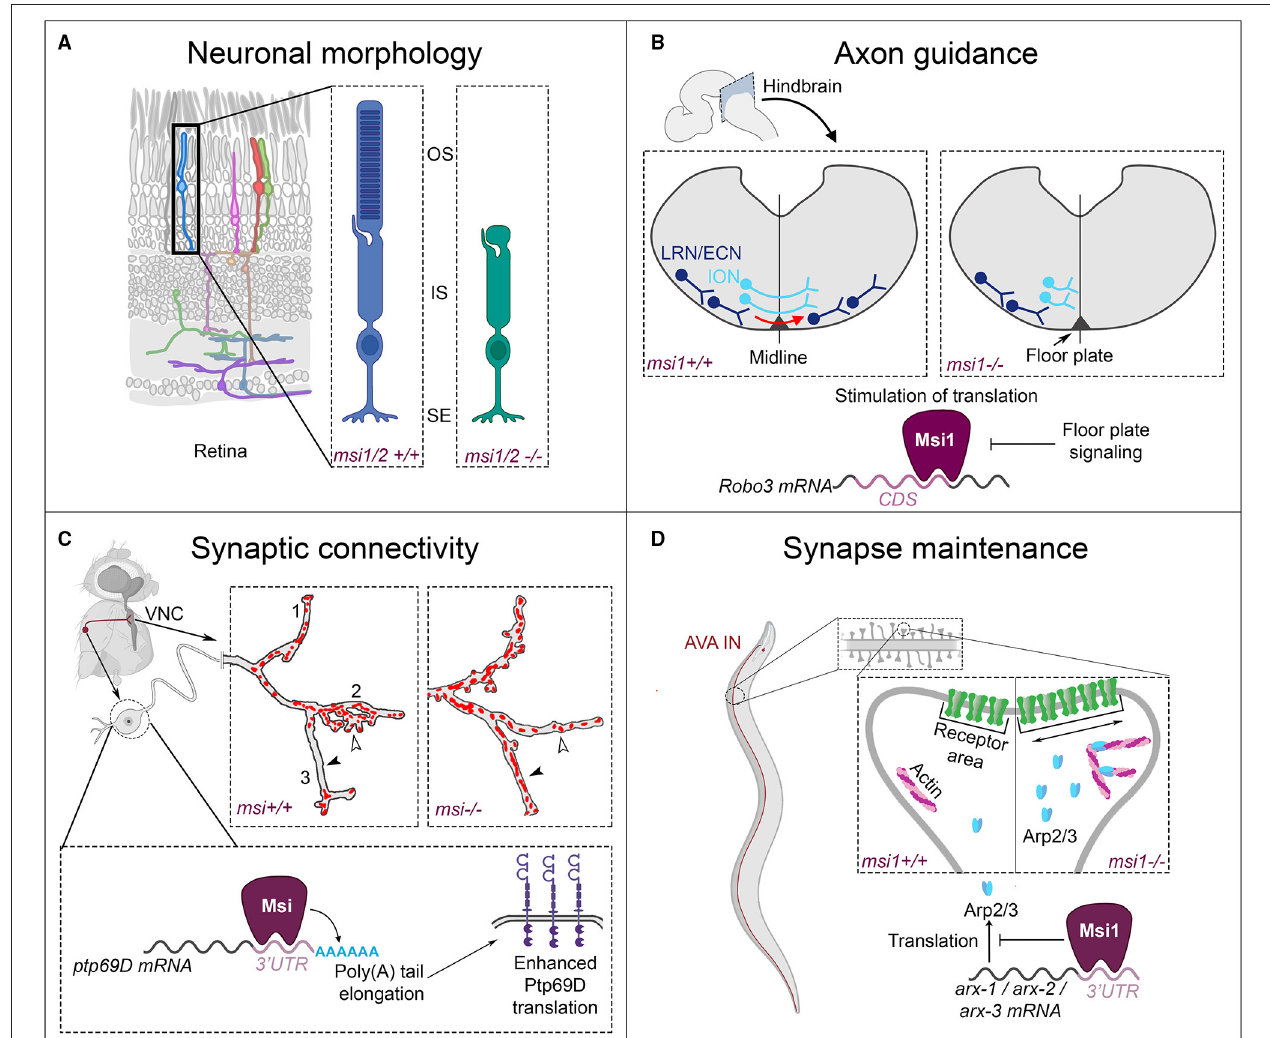
FIGURE 4 | The RBP Musashi as a master regulator of neuronal wiring. (A) Msi proteins control the morphology of photoreceptors. In the mouse retina, Msi1 and Msi2 are required for the correct formation of the outer segment (OS) in photoreceptors. Moreover, in animals lacking Msi1/2, photoreceptors have impaired light response and increased degeneration. These phenotypes are attributed to dysregulation of a Msi1/2-dependent splicing program. IS, inner segment; SE, synaptic ending. Cartoon of retina reproduced from Baden, Tom (2020); Zebrafish retina (adult); Zenodo; https://doi.org/10.5281/zenodo.3926525. (B) Msi1 controls midline crossing of precerebellar neurons in mice. The precerebellar lateral reticular neurons (LRN) and external cuneate nucleous neurons (ECN) migrate toward the ventral midline and both the processes and the cell bodies cross the ventral midline. The inferior olivary neurons (ION) also migrate toward the ventral midline, but only their processes cross the midline. In animals lacking Msi1, midline crossing and neuronal migration of IO and LR/EC neurons are impaired. Msi1 binds to the coding sequence (CDS) of the Robo3 mRNA to enhance protein levels of the Robo3 receptor. When the neurons are approaching the ventral midline, signaling from the floor plate inhibits Msi1 expression, which reduces Robo3 translation. The temporal and spatial regulation of Robo3 translation is required for the midline crossing of precerebellar neurons. (C) Msi controls axon collateral branch-specific synaptic connectivity of mechanosensory neurons in Drosophila . The mechanosensory neurons innervate bristles on the dorsal thorax of the fly and extend their axon to the ventral nerve cord (VNC). The axon forms three collateral branches that innervate the anterior (1), contralateral (2), and posterior (3) regions of the VNC, respectively. Msi specifically promotes the formation of terminal arborizations and a high number of synapses in branch 2 (open arrowhead). By contrast, in branch 3, Msi prevents ectopic synaptogenesis (filled arrowhead). These antagonistic, compartment-specific functions of Msi may depend on the regulation of different mRNA targets. For the function observed in branch 2, Msi binds to the 3 ′ UTR of the mRNA encoding the receptor protein tyrosine phosphatase Ptp69D (bottom). Msi enhances poly(A) tailing and stability/translation of the ptp69D mRNA . For the function observed in branch 3, the relevant target(s) have not yet been identified. (D) Msi1 controls synapse size after associative learning in the Caenorhabditis elegans AVA interneuron. In wild-type animals, synapse/dendritic spine size increases during learning, and it is decreased via a Msi1-dependent mechanism during forgetting. Msi1 binds to the 3 ′ UTR of transcripts coding for components of the actin branching regulator Arp2/3 to down-regulate its translation. The decrease in levels of the ARP2/3 complex leads to a reduced ramification of actin filaments, which correlates with the decrease in synapse size. In animals lacking Msi1, the translation of Arp2/3 complex components is not inhibited and synapse size remains high, leading to a failure to forget.